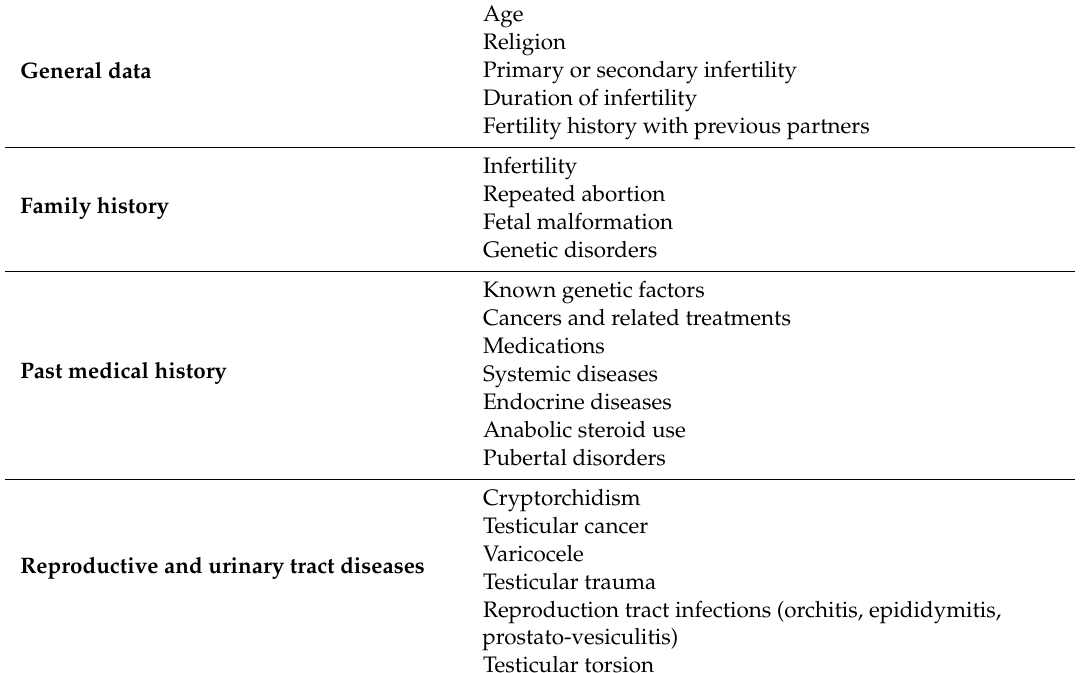
Table 2. Scheme of history taking for the male partner of an infertile